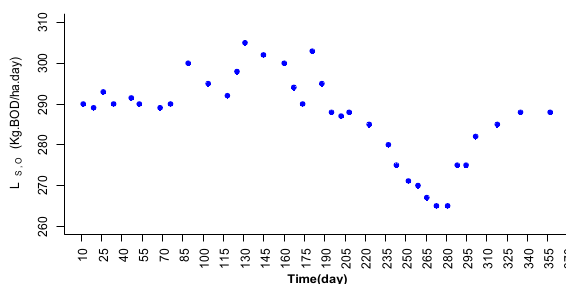
Fig. 3. Diagram of surface loading entry during